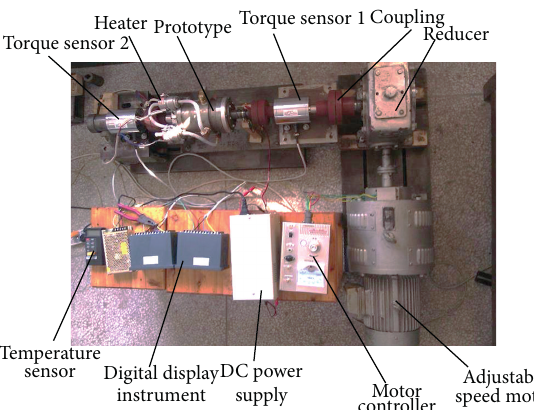
Figure 5: The performance experimental system for cylindrical- type MR fluid transmission driven by shape memory alloy.